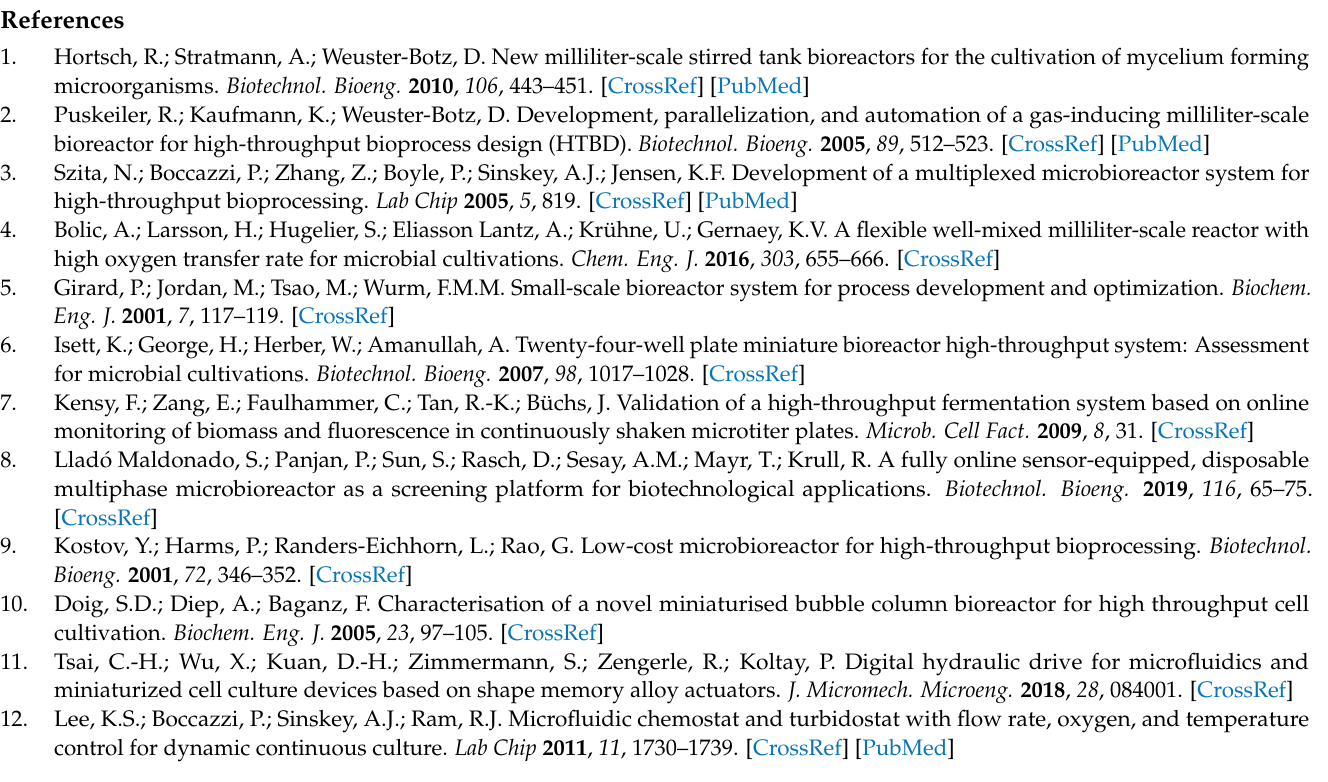
RB11 pC10- FMD (P FMD -GFP) cultivations in SYN6 medium at eight different initial cell dry weights (CDWt0) and glycerol (Glyt0) concentrations in sixfold replicates.; Figure S6: Root-mean-square error for (A,D) glycerol, (B,E) cell dry weight and (C,F) pH value for PLS models with one to six LVs, based on 2D spectra of Hansenula polymorpha RB11 pC10- FMD (P FMD -GFP) cultivations in SYN 6 medium at different initial cell dry weights and glycerol concentrations.; Figure S7: Results for (A,B) calibration and (C,D) prediction of the duplicate-based PLS models generated for cell dry weight (CDW) including (A,C) two and (B,D) six latent variables and linear interpolation for a 6 h sampling interval, based on 2D spectra of Hansenula polymorpha RB11 pC10- FMD (P FMD -GFP) cultivations in SYN6 medium at different initial cell dry weights (CDW t0 ) and glycerol (Gly t0 ) concentrations.; Figure S8: (A–C) Calibration and (D–F) prediction of the PLS model generated by including two latent variables and linear interpolation for a 6 h sampling interval for (A,D) residual glycerol, (B,E) CDW and (C,F) pH value based on averaged 2D spectra.; Figure S9: Parity plots for the average-based PLS prediction of offline parameters (A) glycerol, (B) cell dry weight (CDW) and (C) pH value using two latent variables on averaged 2D spectra from six replicates of Hansenula polymorpha RB11 pC10- FMD (P FMD -GFP) cultivations in SYN6 medium at different initial cell dry weights (CDW t0 ) and glycerol (Gly t0 )